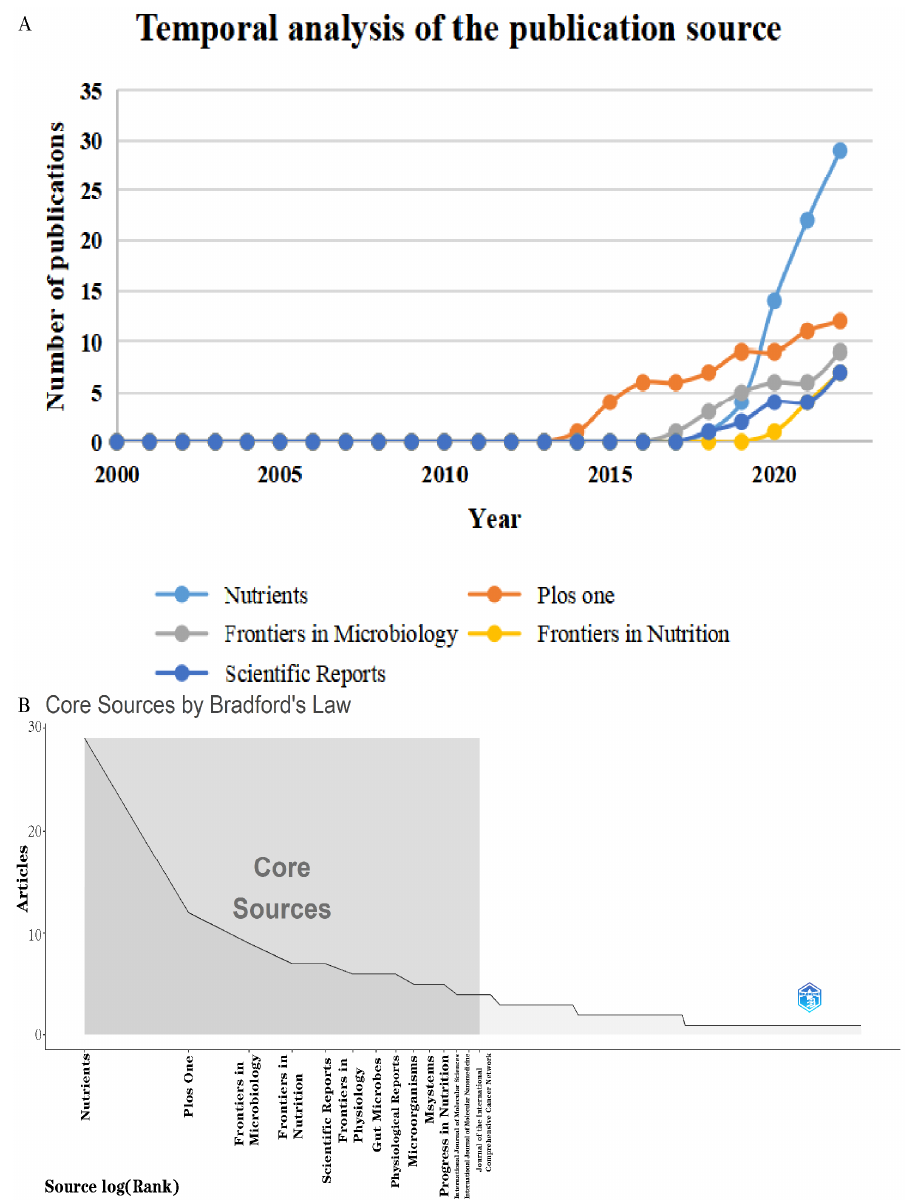
Figure 5. ( A ) Temporal analysis of the publication source. ( B ) Core sources classified by Bradford’s Law.